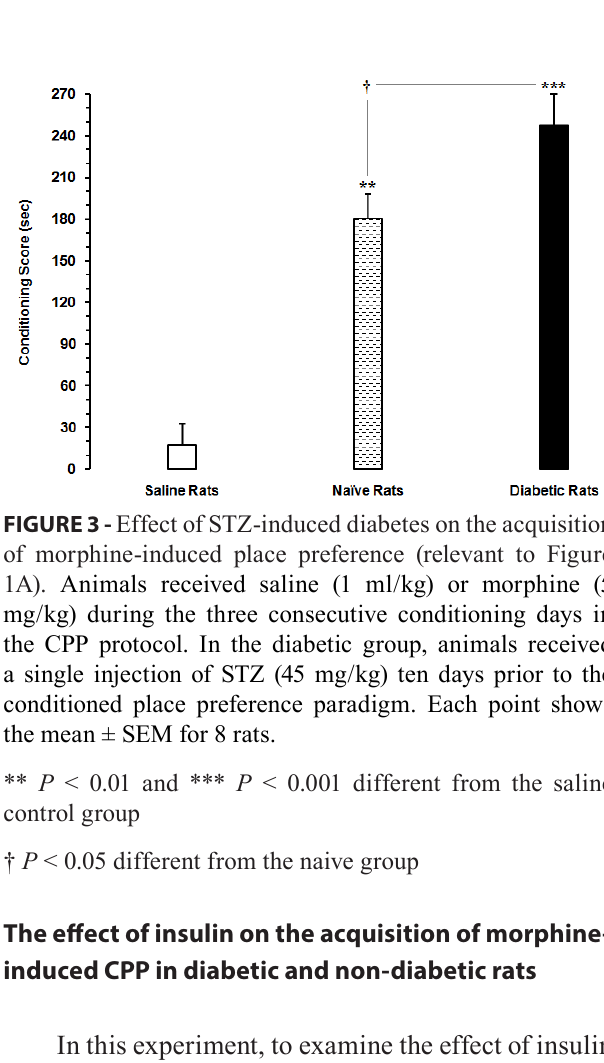
FIGURE 2 - One week after STZ injection, diabetes was verified by measuring (A) fast blood glucose level (mg/dl) and (B) body weight (gr). As depicted here, there is a significant difference in both variables in naïve and diabetic rats (as a result of STZ induced diabetes mellitus) simultaneously. Each point shows the mean ± SEM for 8 rats. ** P < 0.01 and *** P < 0.001 different from the naive